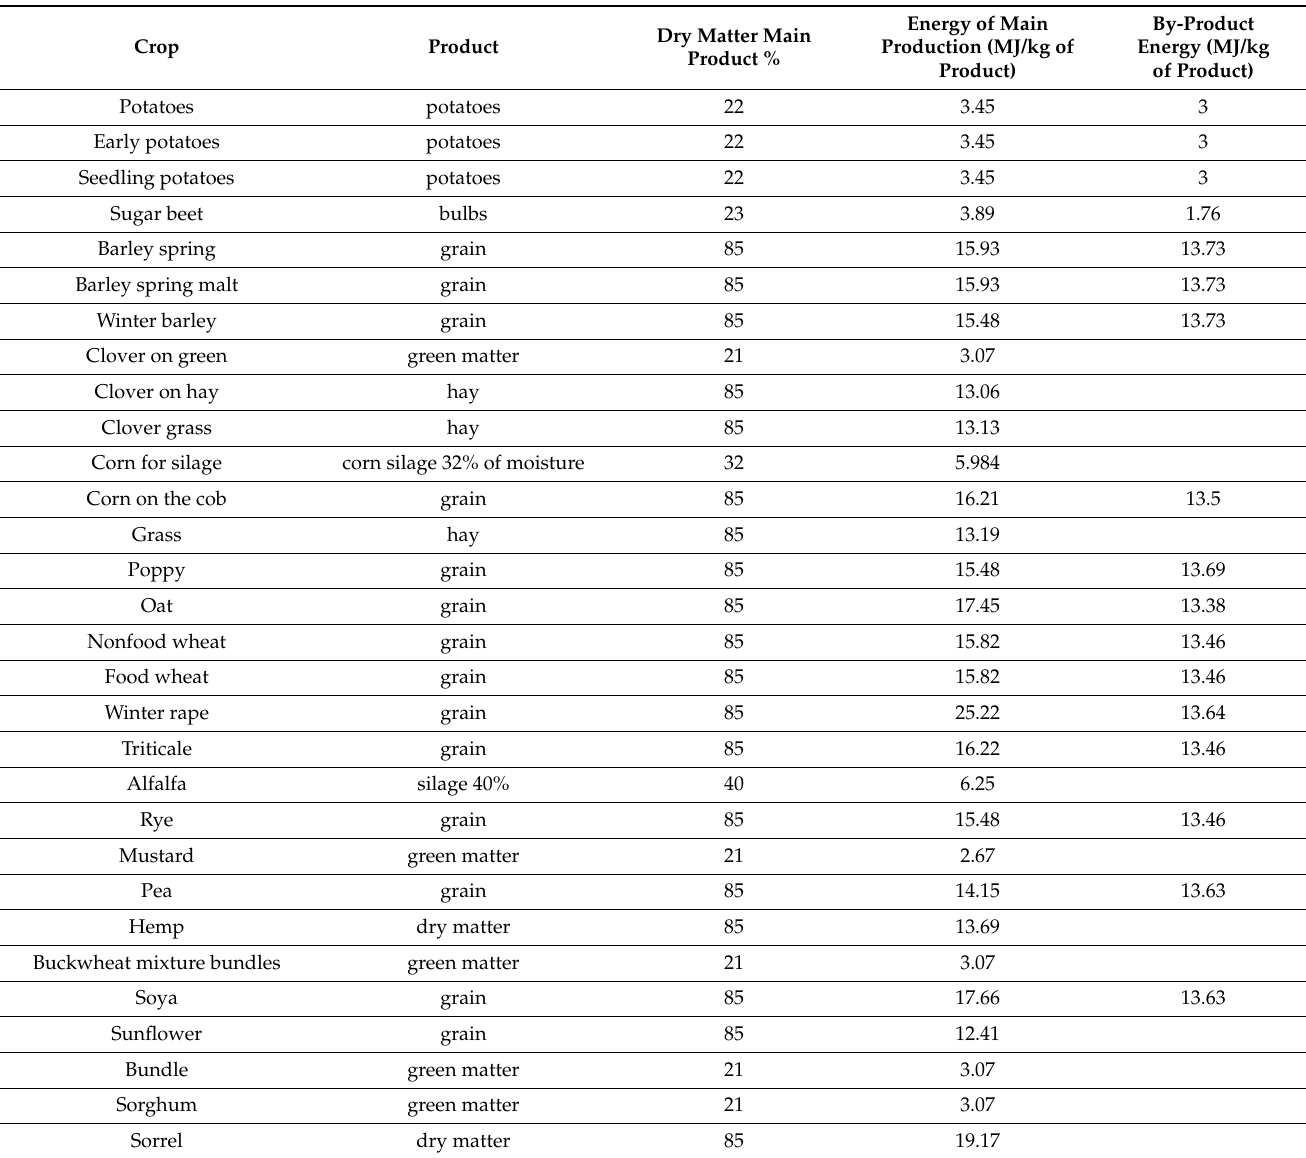
Table A3. Energy of crop production.